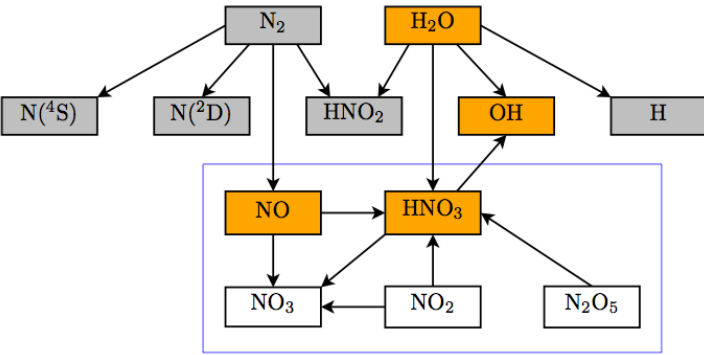
Fig. 1. A diagram of hydrogen and nitrogen conversions due to ionic reactions. The species in the grey boxes are produced by positive ion chemistry, while NO y redistribution by negative ion chemistry affects the species inside the blue box. NO, HNO 3 , OH, and H 2 O are directly affected by both positive and negative ion chemistry (orange boxes). Note that the effects of neutral reactions (e.g. production of NO from N ( 2 D ) ) are not included in the